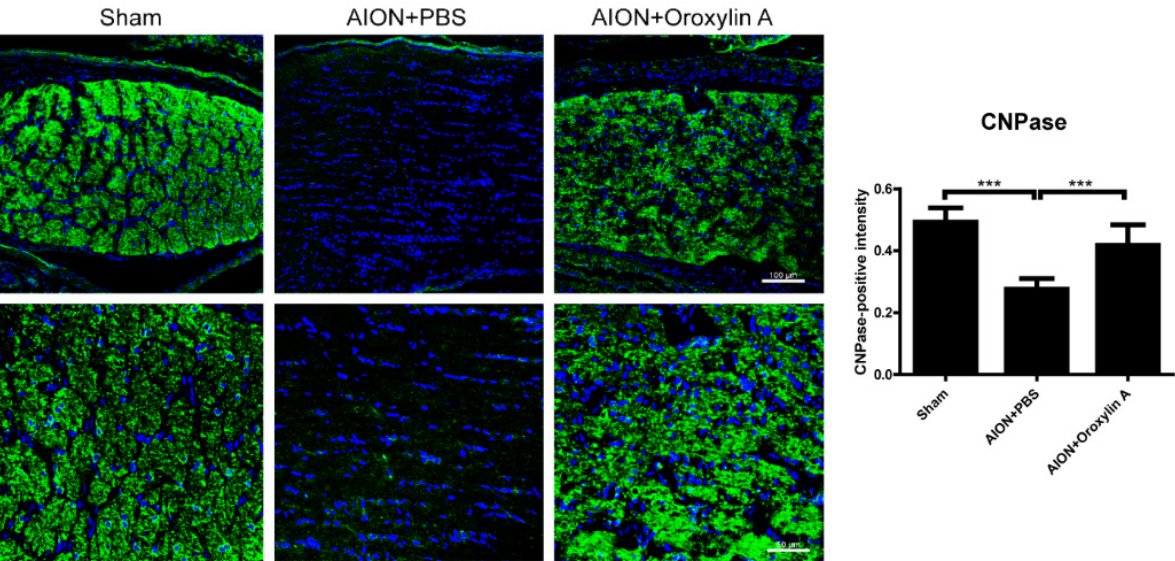
Figure 8. IHC of 2 ′ , 3 ′ -cyclic nucleotide 3 ′ -phosphodiesterase (CNPase) in the ON 4 weeks after rAION induction. Green fluorescence represents CNPase-positive cells, and blue florescence represents nuclei. The columns indicate the intensity of the green fluorescence of CNPase-positive cells. The columns indicate that the numbers of CNPase-positive intensity (green) per DAPI in the sham group, PBS-treated group, and OA-treated group were 0.49 ± 0.047, 0.28 ± 0.035, and 0.42 ± 0.067 intensity/DAPI, respectively. Scale bar, 100 µ m (upper), 50 µ m (lower); Results represent the means ± SDs, n = 6 in each group. *** p ≤ 0.001.